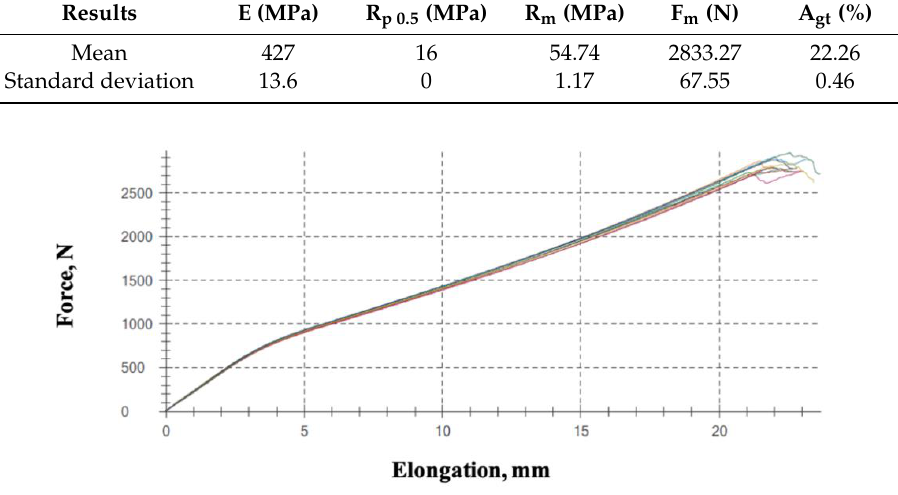
Figure 5. Force versus elongation of conveyor belt samples.